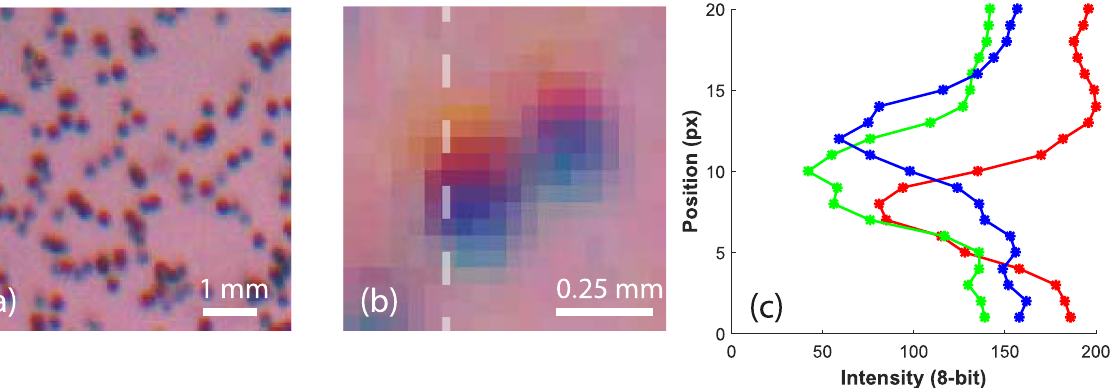
Figure 8. ( a ) Particle images with the three color LED’s flashed simultaneously, i.e. with zero time-delay. ( b ) Close-up of two particles, which shows clearly the effects of the chromatic aberrations in one of the most affected areas, near the edge of the image. ( c ) The color profiles of a single particle, taken along the dashed line in ( b ). One can clearly see the vertical shifting of the colored shadows, due to the chromatic aberrations.